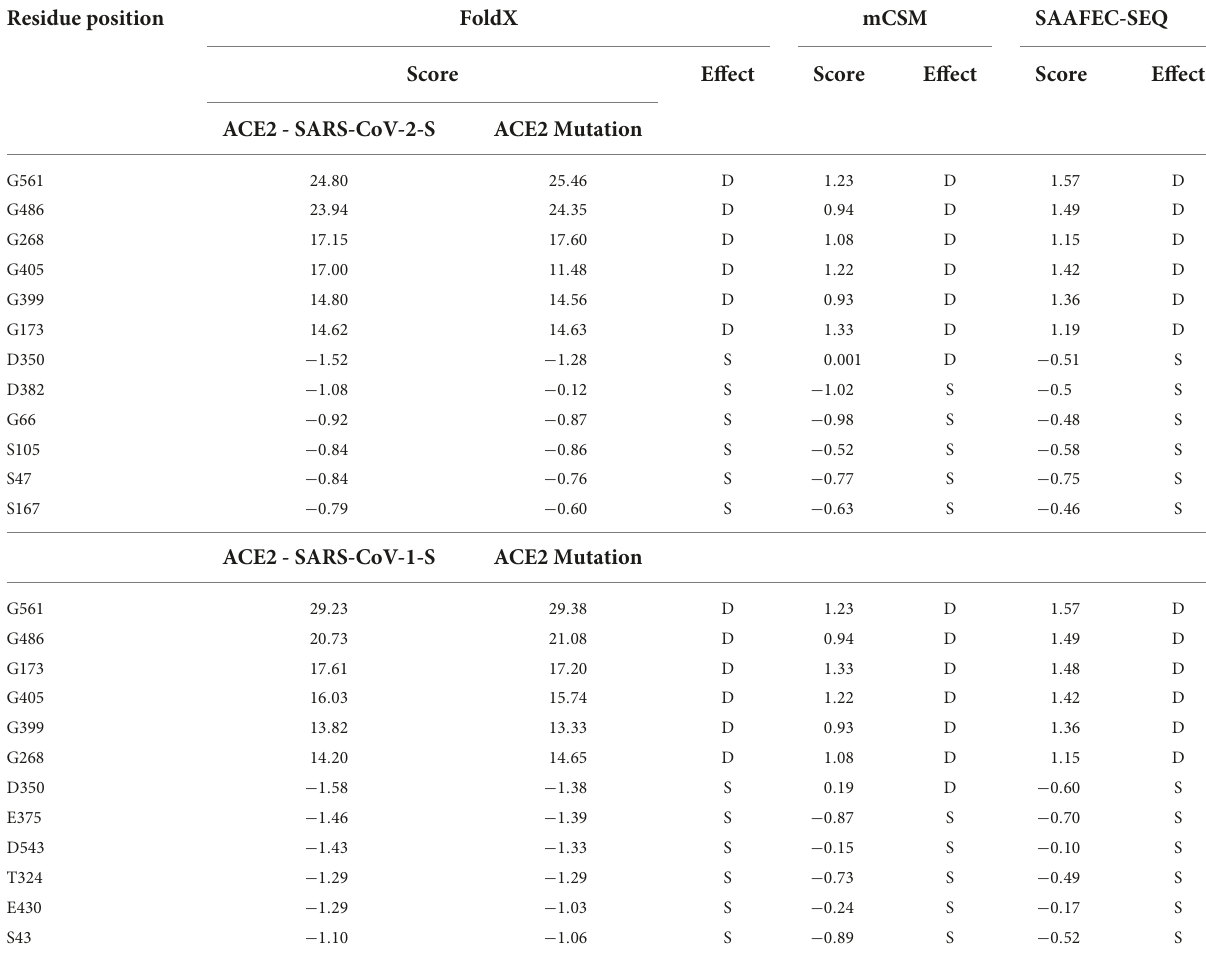
TABLE 1 Comparison of target mutations among different computational tools on ACE2 – SARS-CoV-1-S/ACE2 – SARS-CoV-2-S (cid:49)(cid:49) G Mean (kcal/mol). Residue position FoldX mCSM SAAFEC-SEQ Score Effect Score Effect Score Effect